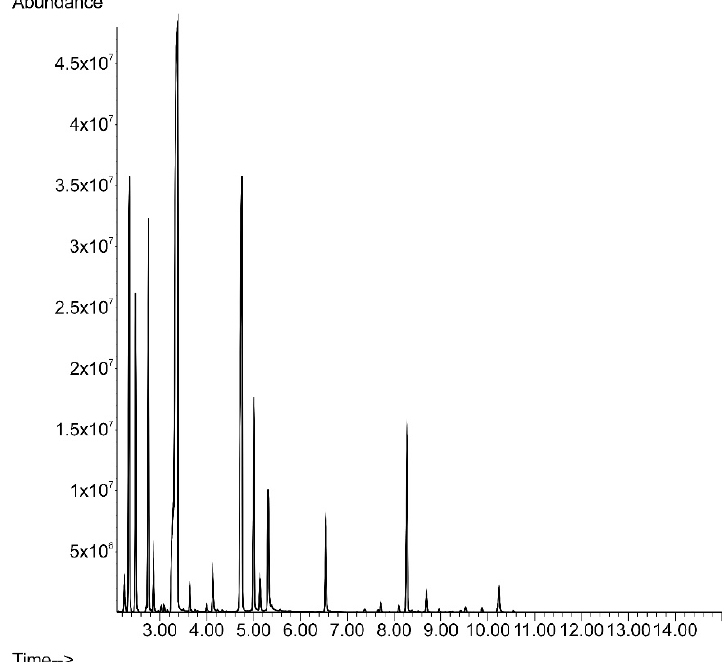
Figure A4. The gas chromatogram of the rosemary commercial oil. Dilution 1:40 ( v / v ) in dichloromethane.